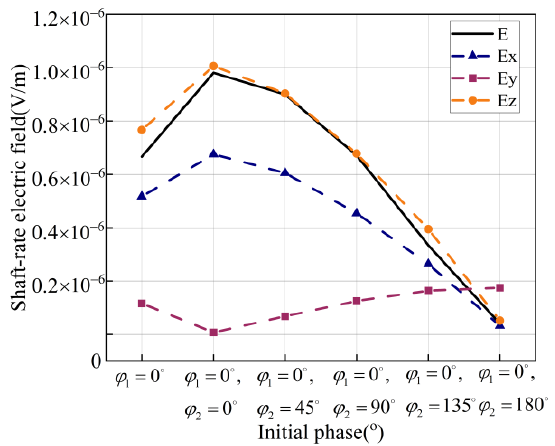
Figure 12. Relationship between ship shaft-rate electric field and initial value of shafting equivalent